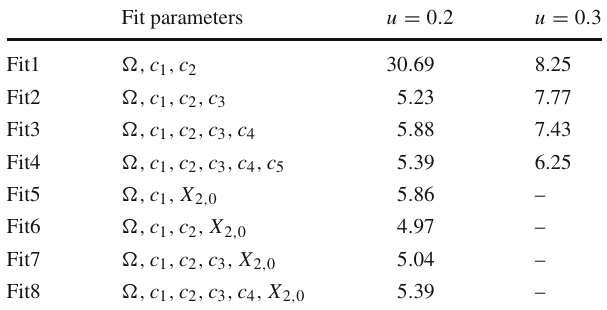
Table 4 Summary of χ 2 / d.o.f. for different types of fits of ˆ w 0 versus β . Here (cid:9) = w (cid:4) 0 Lat Fit